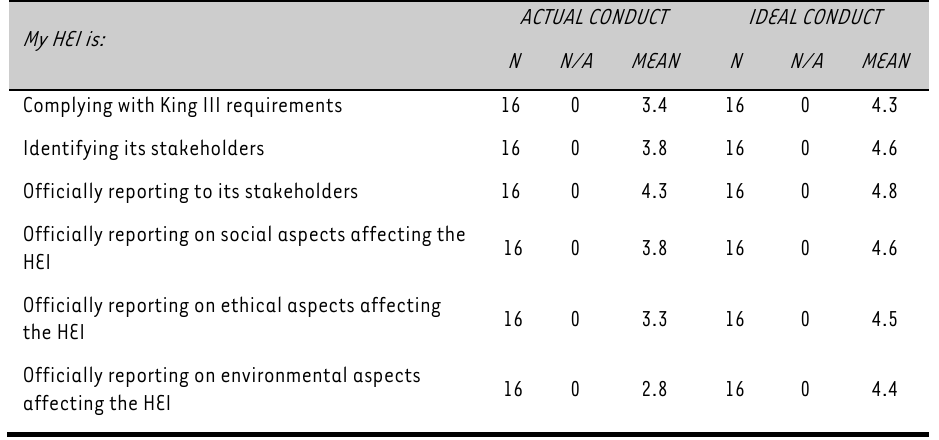
TABLE 6 Social environmental and governance